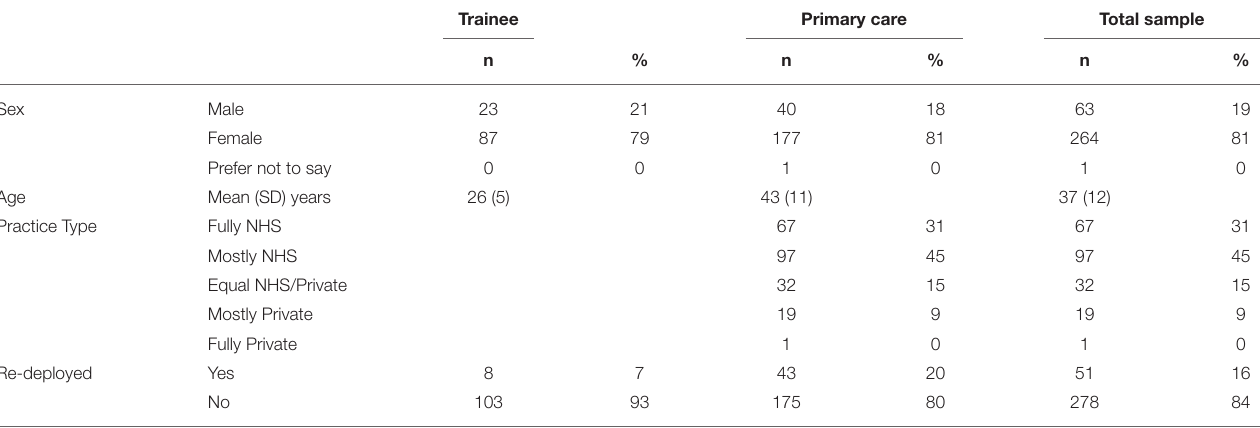
TABLE 1 | Demographics, practice composition and deployment status. Trainee Primary care Total sample